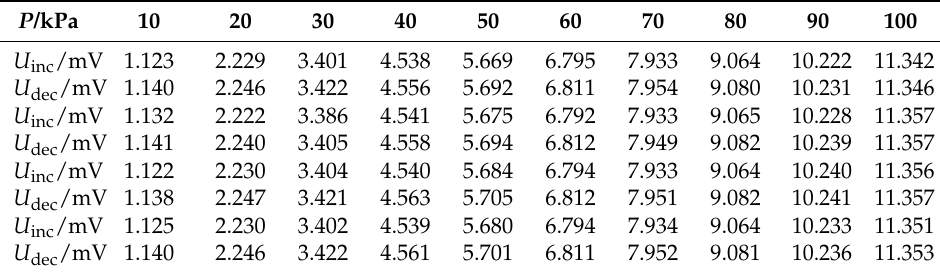
Table 3. The output voltages of the array-type sensor without compensation during the pressure increasing and pressure decreasing cycle at 20 °C.